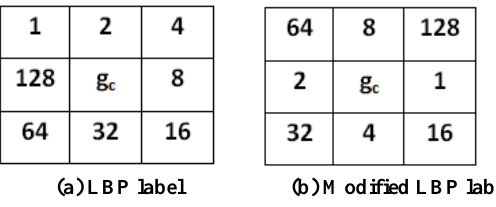
Figure 1. Labels for local area of 3 × 3 with center pixel g c